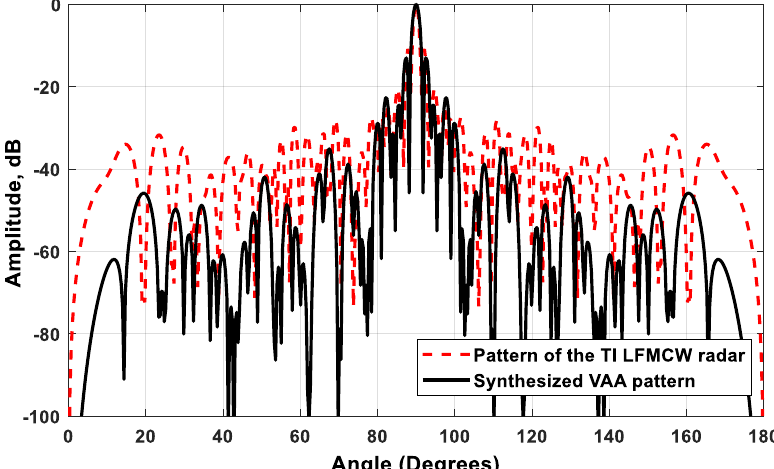
Figure 15. Radiation pattern of the proposed VAA compared to the traditional TI’ LFMCW radar pattern.